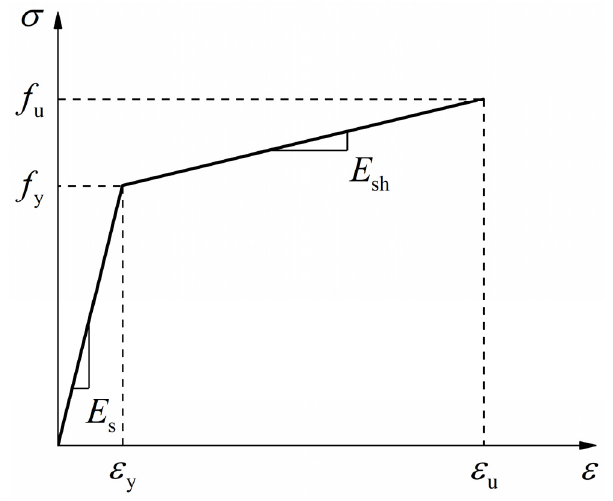
Figure 5. Stress–strain relationships used for steel